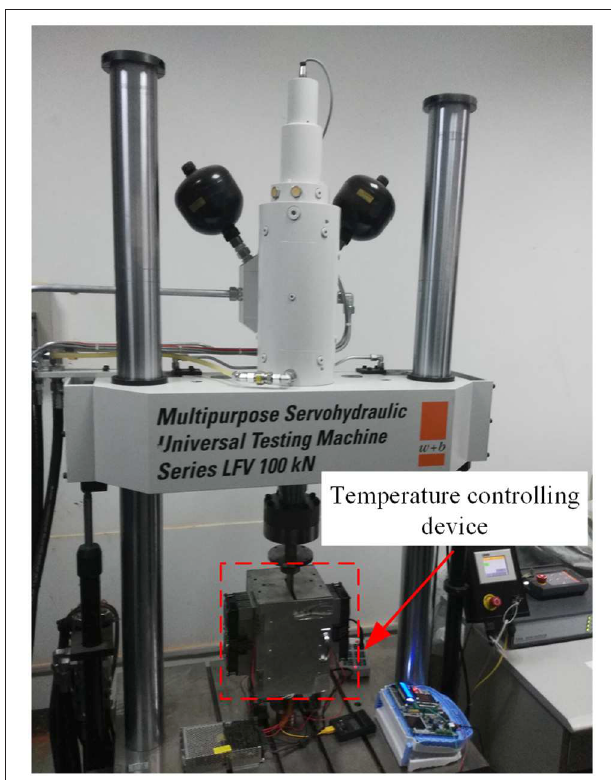
FIGURE 2 | Properties tests of the viscoelastic damper.